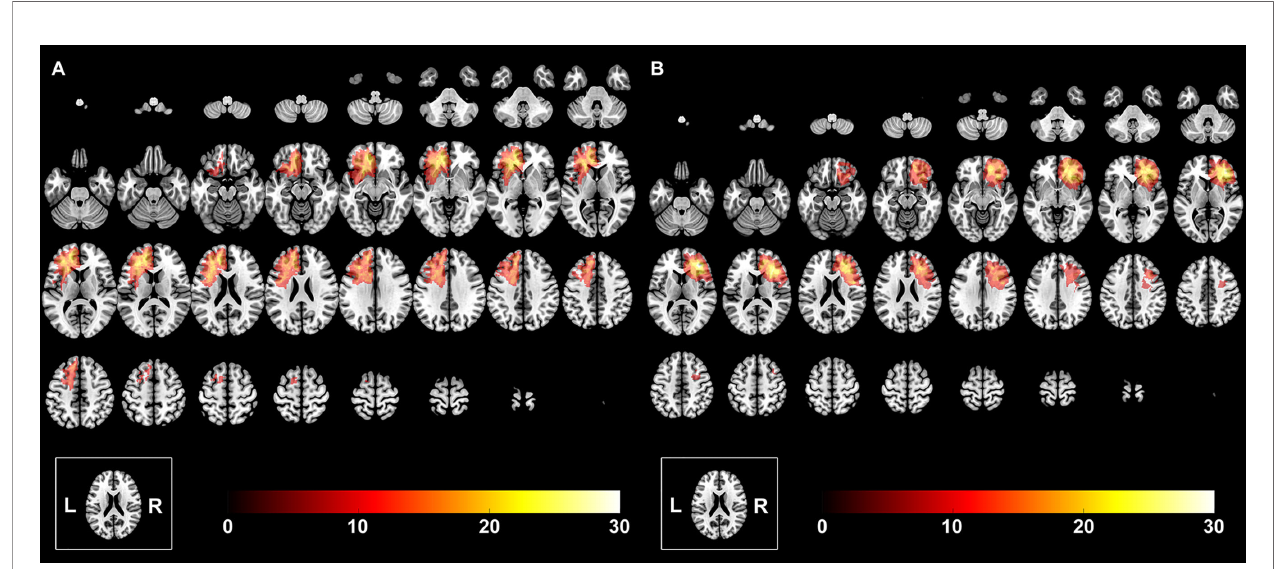
FIGURE 1 | The overlapping results of prefrontal lobe gliomas. The overlapping meant that we overlapped all the tumor masks of the left hemisphere into one template to show the quantitative distribution of the left hemispheric gliomas. The value of the color bar represents the number of patients with tumor located in the same region. (A) Tumor was in the left hemisphere. (B) Tumor was in the right